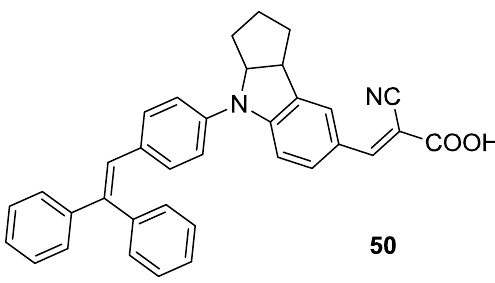
Figure 41. D131 structure used in cosensitization [165,166].